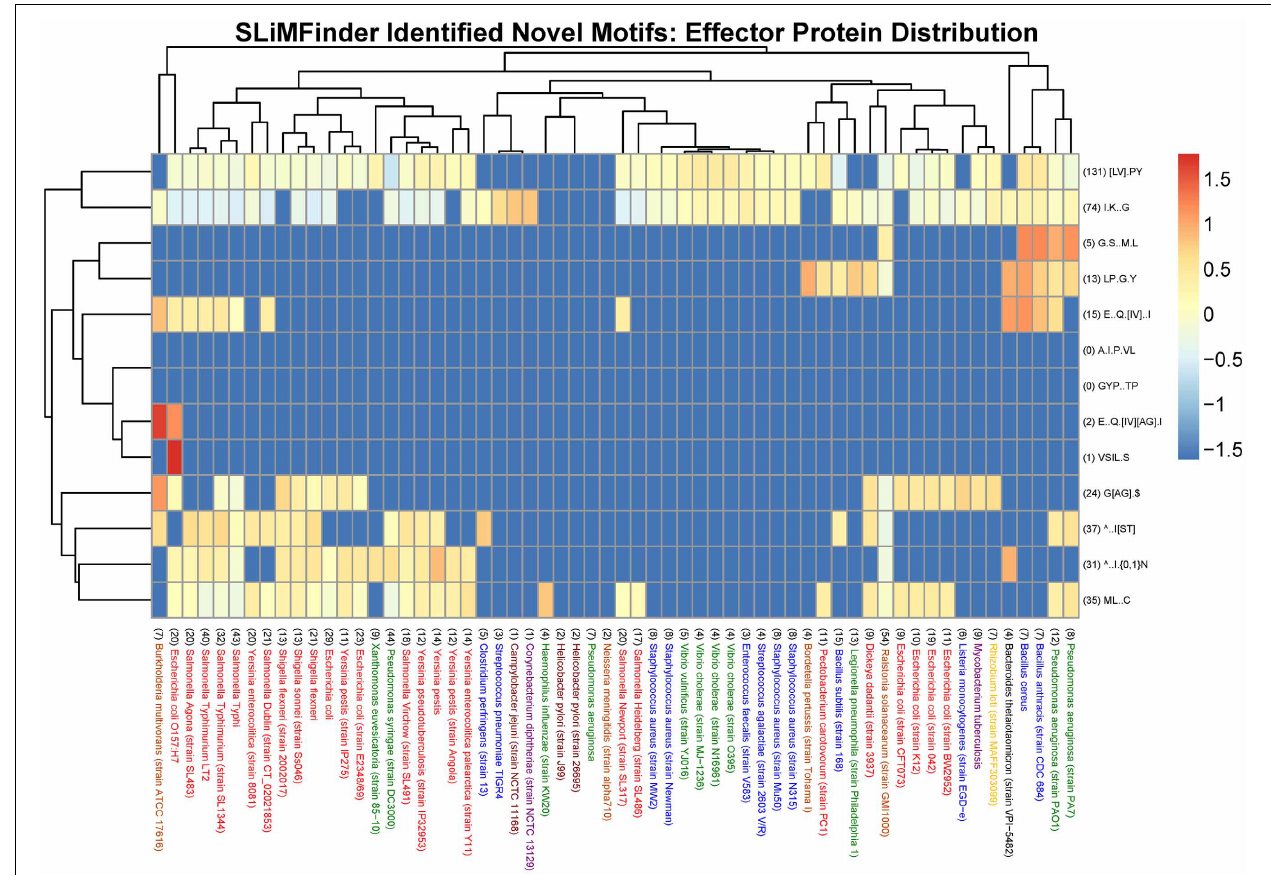
FIGURE 2 | Heat map visualization of the distribution of novel SliMFinder identified motifs amongst effector proteins from a selection of 60 organisms represented in the MvirDB. Columns: The bacterial species name with the total number of UPCs indicated in brackets at the start of the description. Purple, High GC Gram+ bacteria; Blue, Firmicutes; Yellow, a-proteobacteria; Light Brown, b-proteobacteria; Dark Brown,